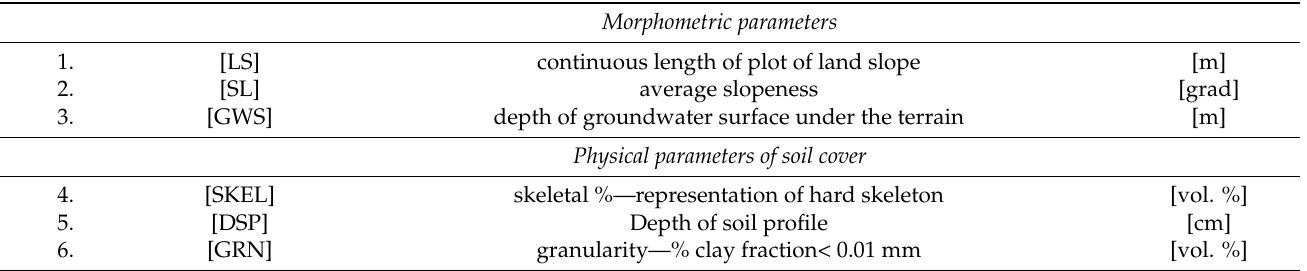
Table 2. The list of used indicators in describing elements of the selected agroecosystem and means of their